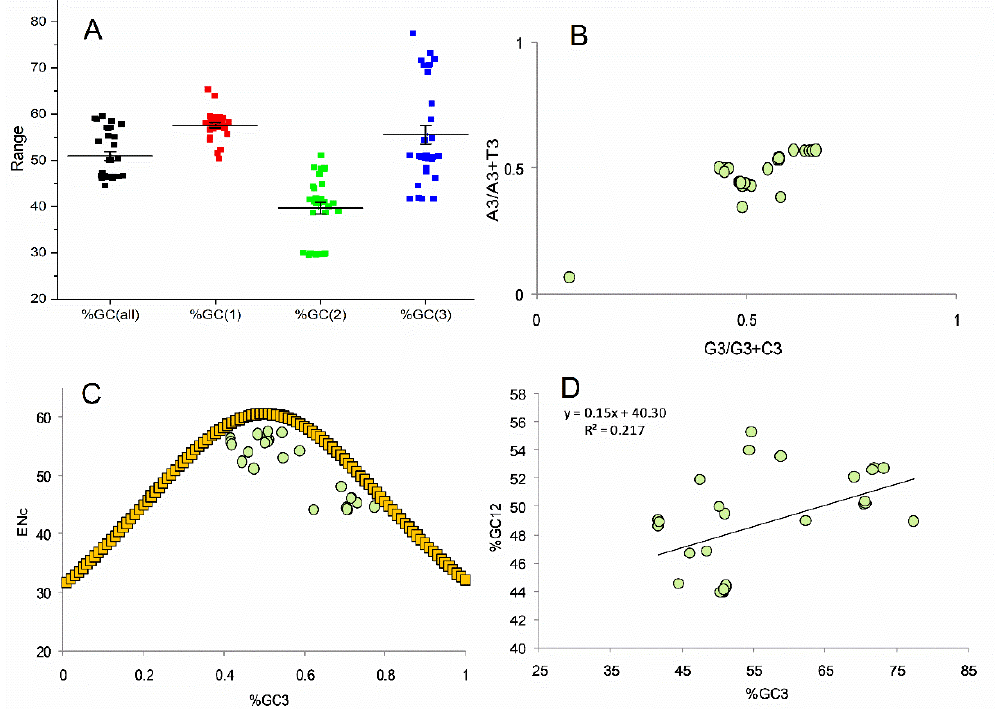
Figure 1. ( A ). Overall %GC composition and %GC composition at all the three codon positions ( B ). Parity pot analysis ( C ). ENc-GC3 analysis ( D ). Neutrality